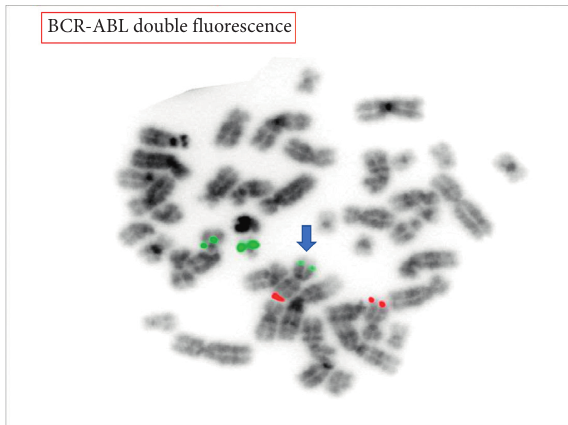
Figure 2: Fluorescent in situ hybridization with probes for BCR (22q11.2, green signal) and ABL1 (9q34.1, red signal) was negative for a BCR-ABL1 rearrangement. However, a third signal for the BCR probe (green signal, arrow) was observed, suggesting partial or complete gain of chromosome 22 or a translocation that involves BCR with a partner gene other than ABL1 . Additional testing with a probe for JAK2 (9p24.1, not shown) suggested the presence of a BCR-JAK2 fusion, which was confirmed with RNA